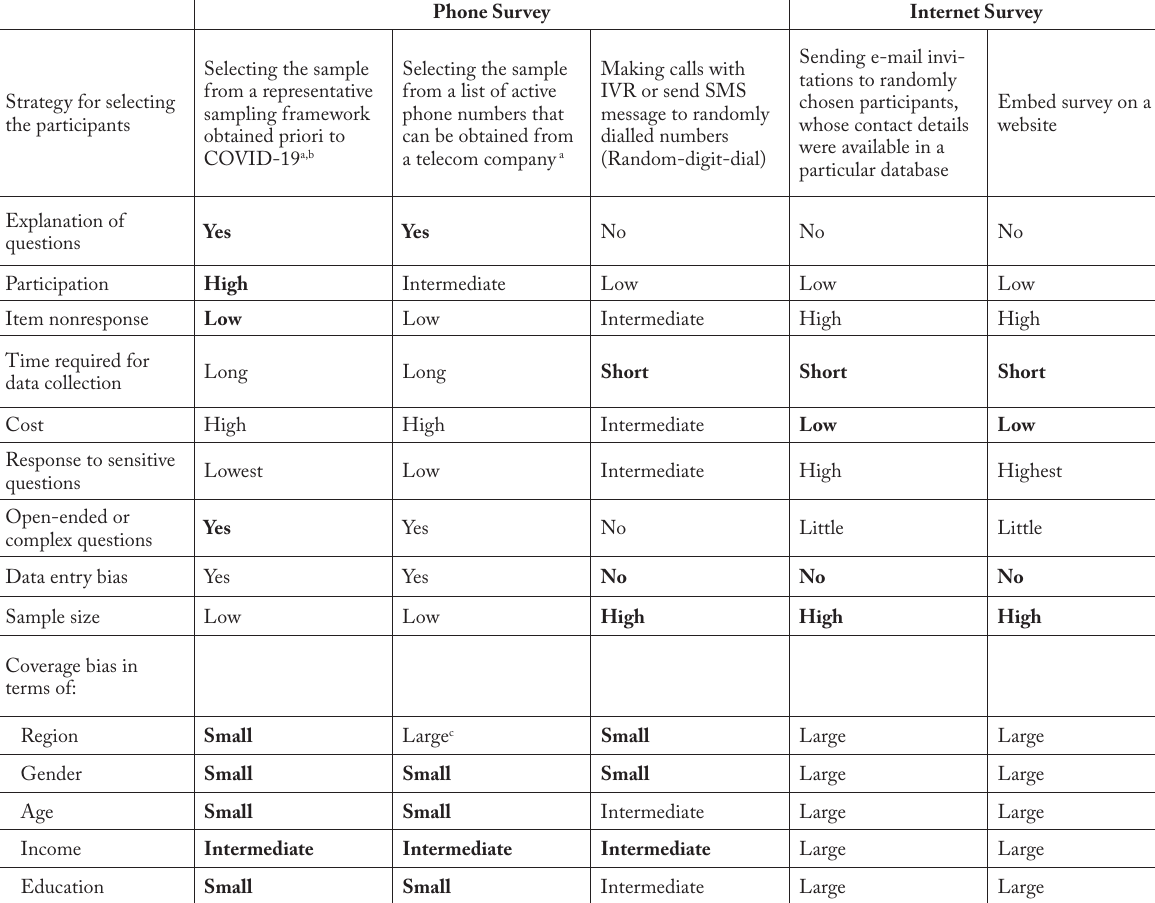
Table 1. Overview of advantages and disadvantages of survey modes and strategies to select